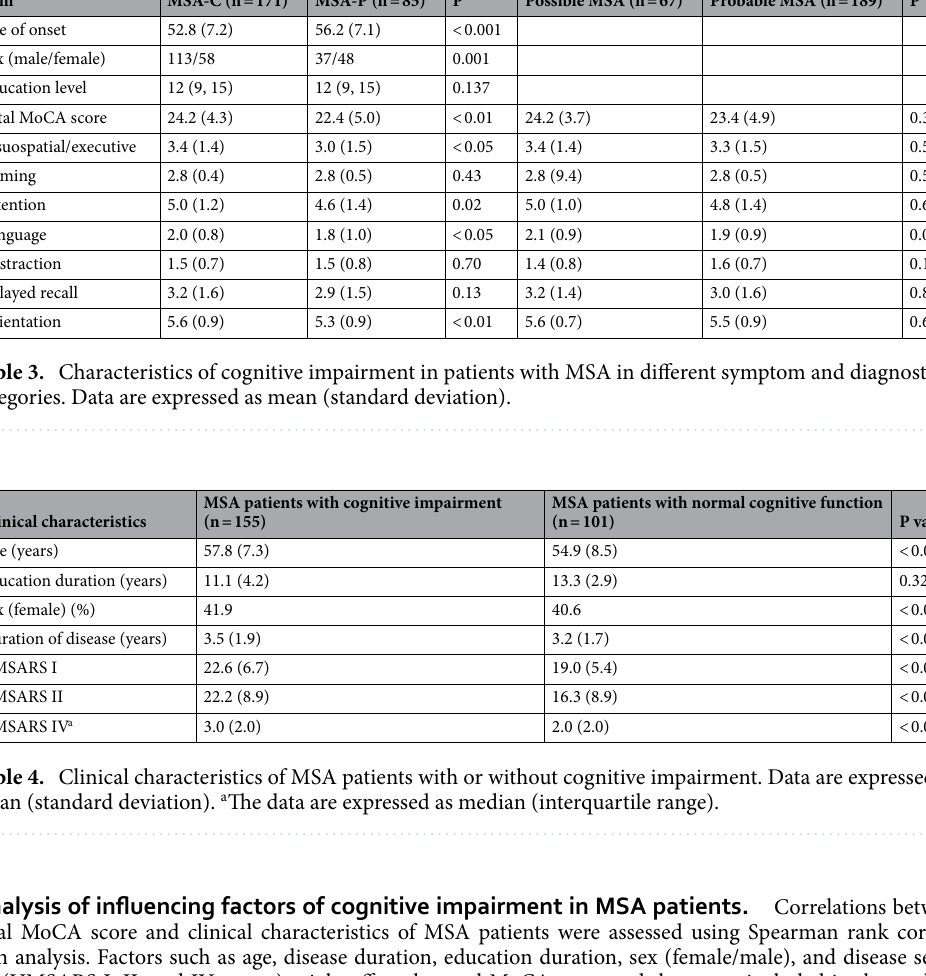
Table 4. Clinical characteristics of MSA patients with or without cognitive impairment. Data are expressed as mean (standard deviation). a The data are expressed as median (interquartile range).